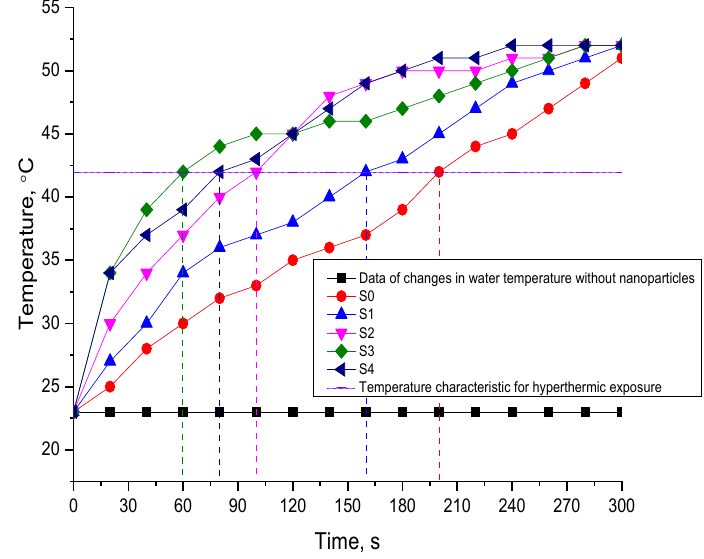
Figure 7. Results of determining the temperature dependences of heating.